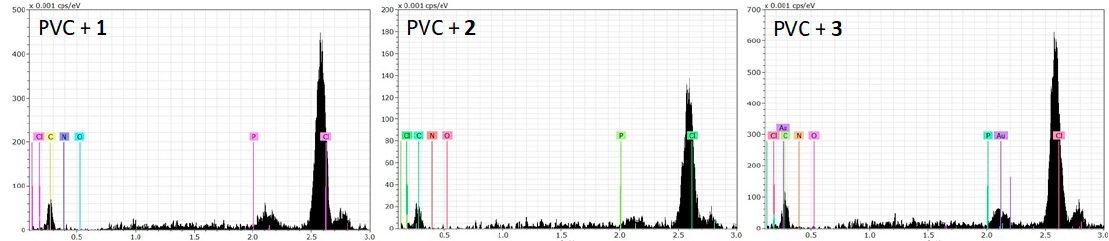
Figure 2. Energy dispersive X-ray (EDX) patterns of PVC films.